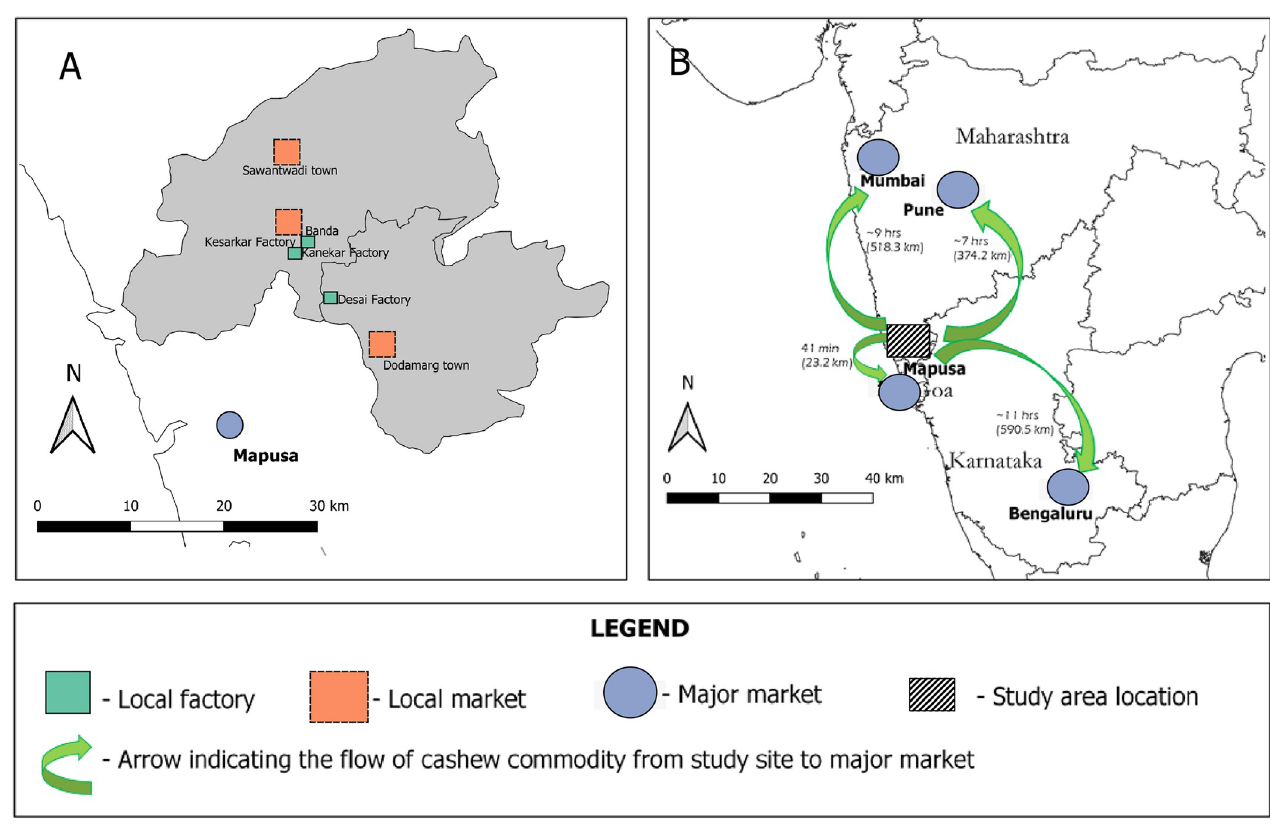
Fig 5. The figure illustrates the locations of (A) local cashew factories and markets in the Sawantwadi-Dodamarg landscape (in grey), and (B) major markets where the cashew commodity produced from the study site is transported to, along with the flow of the commodity in green arrows also showing the distance from study site to the major market and time taken to reach these markets by car. Distances and travel time to Mapusa and Bengaluru were estimated from Dodamarg town, while distances to Mumbai and Pune were estimated from Sawantwadi town (Data sources: https://bhuvan.nrsc.gov.in/home/index.php;